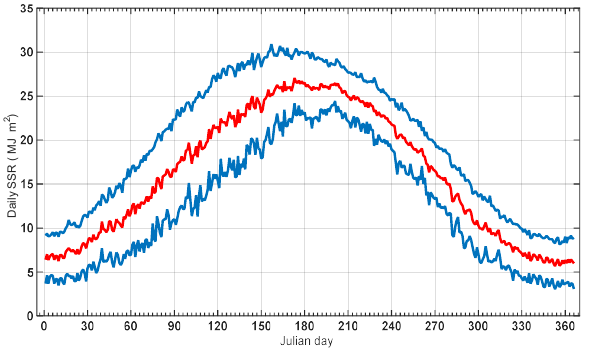
Figure 1. Average intra-annual variability of surface solar radia- tion (SSR) at the Actinometric Station of the National Observatory of Athens (red), along with the interannual variability for a given day ( ± 1standard deviation, blue), calculated over the period 1953–